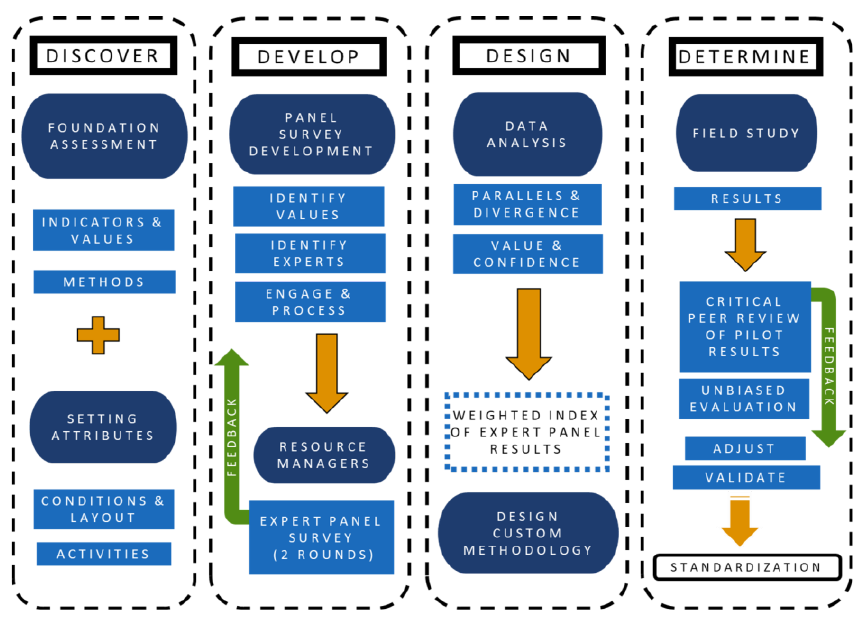
Figure 1. The National Marine Sanctuary Visitor Counting Process (NMS-COUNT) conceptual model illustrating four phases of study for customized application to unique Sanctuary settings. It is described in Burns et al. [20] as a potential method for visitor counting in unique/remote aquatic settings where traditional sampling techniques are not always applicable.